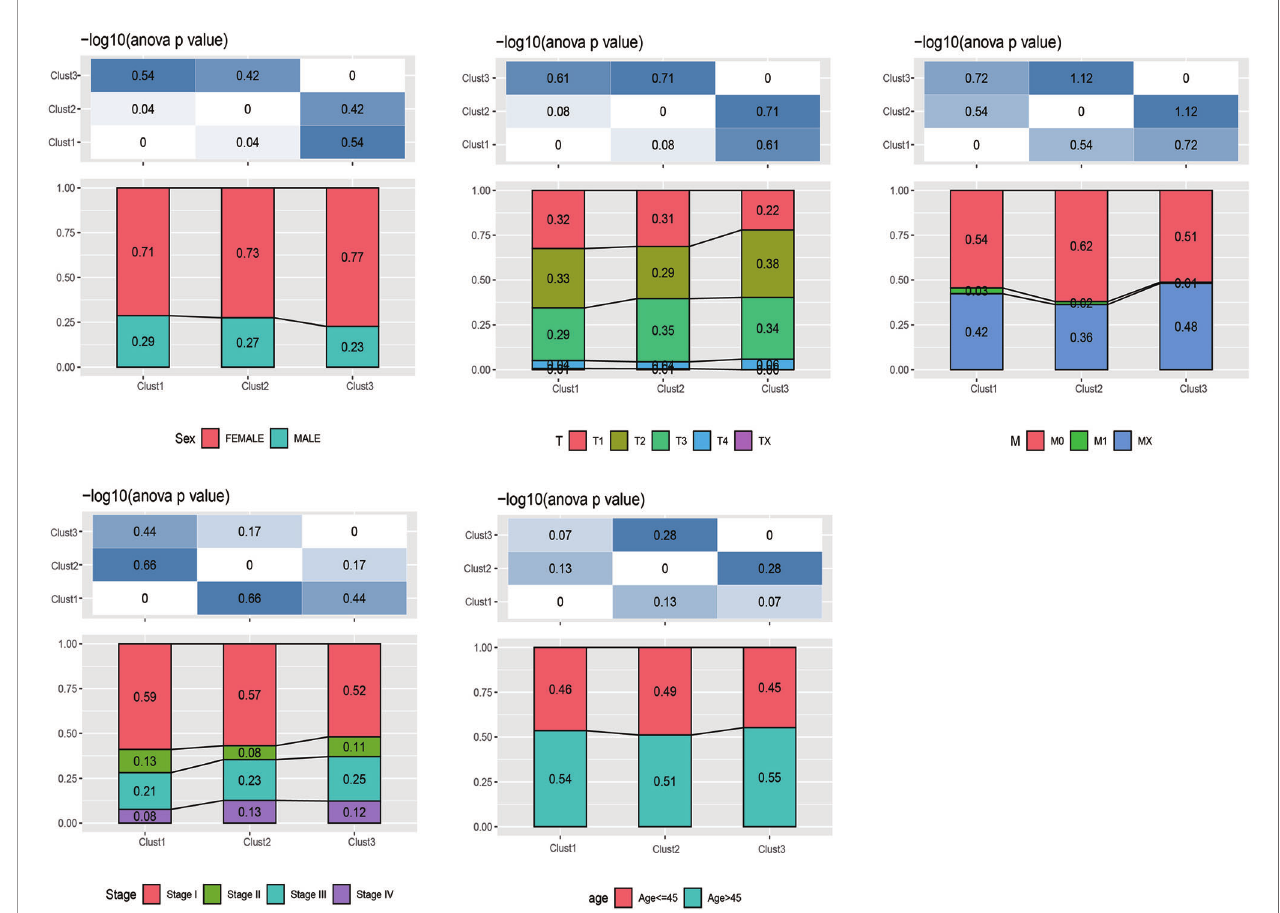
FIGURE 3 | The distribution of clinical features (gender, stage, and age) of samples in the m 5 C-cluster 1 –